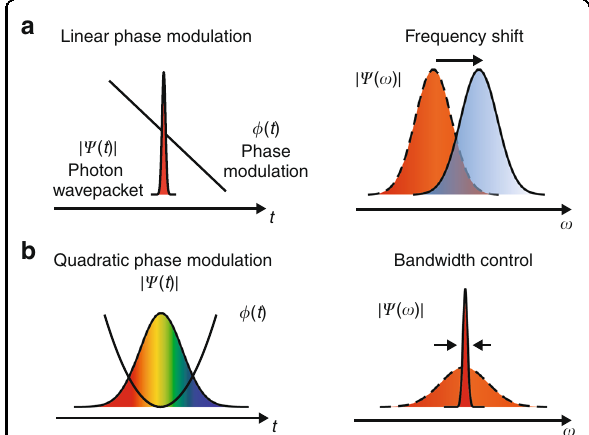
Fig. 1 Frequency and bandwidth control of light through temporal phase modulation. a A linear phase modulation, referred to as spectral shearing, results in a Doppler-like frequency shift. b A quadratic phase modulation, known as time lens, applied to a